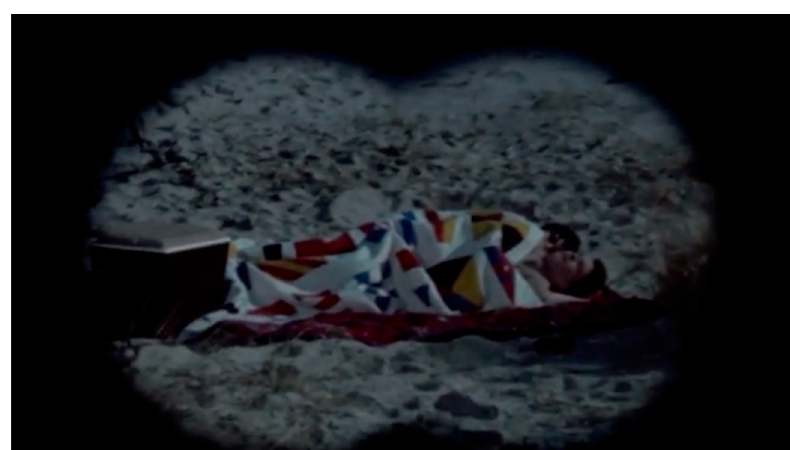
Figure 16. Image from Maniac (1980) [49]. Philosophies 2019 , 4 , x FOR PEER REVIEW